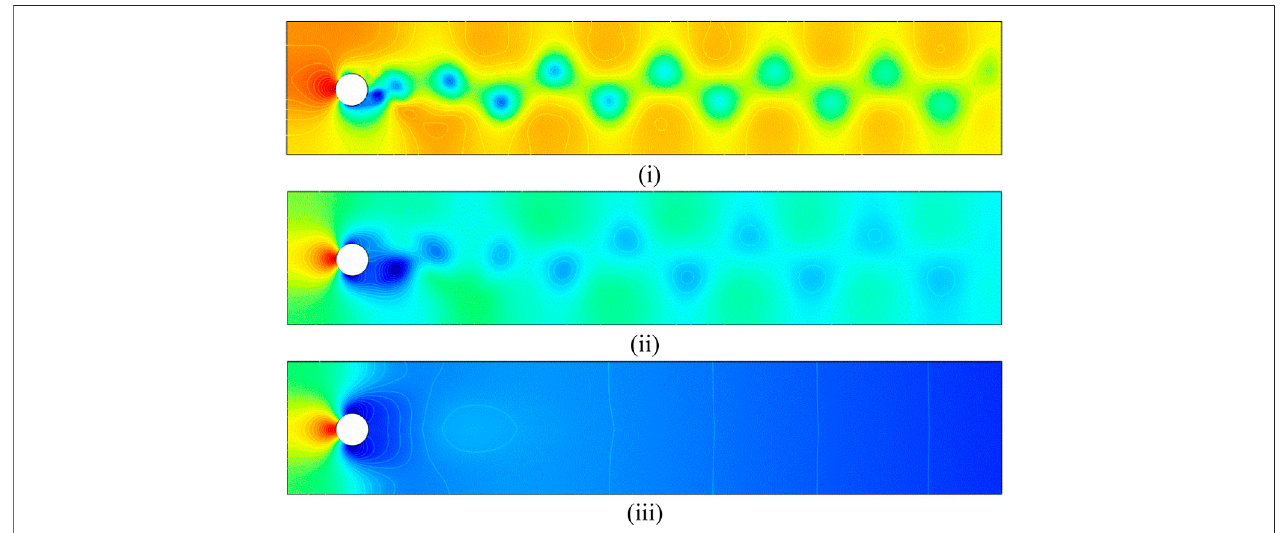
FIGURE 5 | In fl uence on pressure for ( i ) n (cid:2) 0 . 6 , ( ii ) n (cid:2) 1 , ( iii ) n (cid:2) 1 . 4 with Pr (cid:2) 7 and Re (cid:2) 100 at t (cid:2) 5